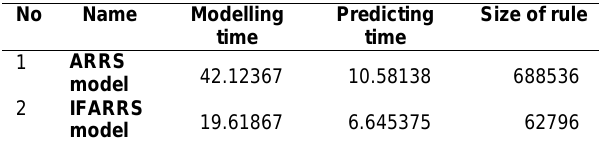
Table 5. Comparison of training time, predicting time and size of the rule set generated by the two